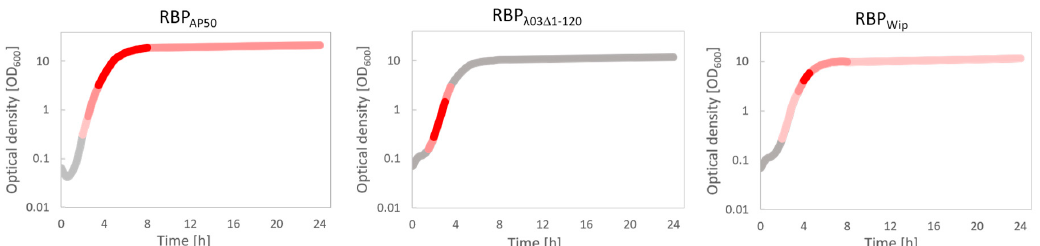
Figure 4. Binding of RBP reporters to B. anthracis cells varies between RBP of di ff erent phages but yields strongest signals during logarithmic growth phase of host cells. Growth experiments were started from germinating B. anthracis Sterne spores and the growth phase was derived from recordings in optical cell densities at 600 nm (OD 600 ). Binding strengths of reporters RBP AP50 , RBP λ 03 ∆ 1-120 or RBP Wip are indicated by colored sections of the growth curves: grey = no binding, light red = weak RBP binding, i.e., either only sporadic binding and / or binding to only a few areas of the cell surface. red: distinct RBP binding (easily recognizable binding to the majority of all cells). dark red = very strong RBP binding ((almost) all cells exhibit very intense fluorescence